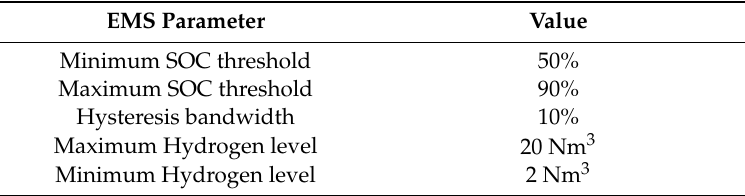
Figure 12. Microgrid power variables: ( a ) renewable (photovoltaic) power (PPV), residential consumption (Pload), electric vehicle consumption (PEV), lead-acid battery power (Pbat_La), and Li-ion battery power (Pbat_Li) for fluctuating solar profile; ( b ) renewable (photovoltaic) power (PPV), residential consumption (Pload), electric vehicle consumption (PEV), hydrogen system power (PH2), and main power grid (PGrid) for fluctuating solar profile. Table 3. Parameters used in the reference study case (hysteresis-based EMS